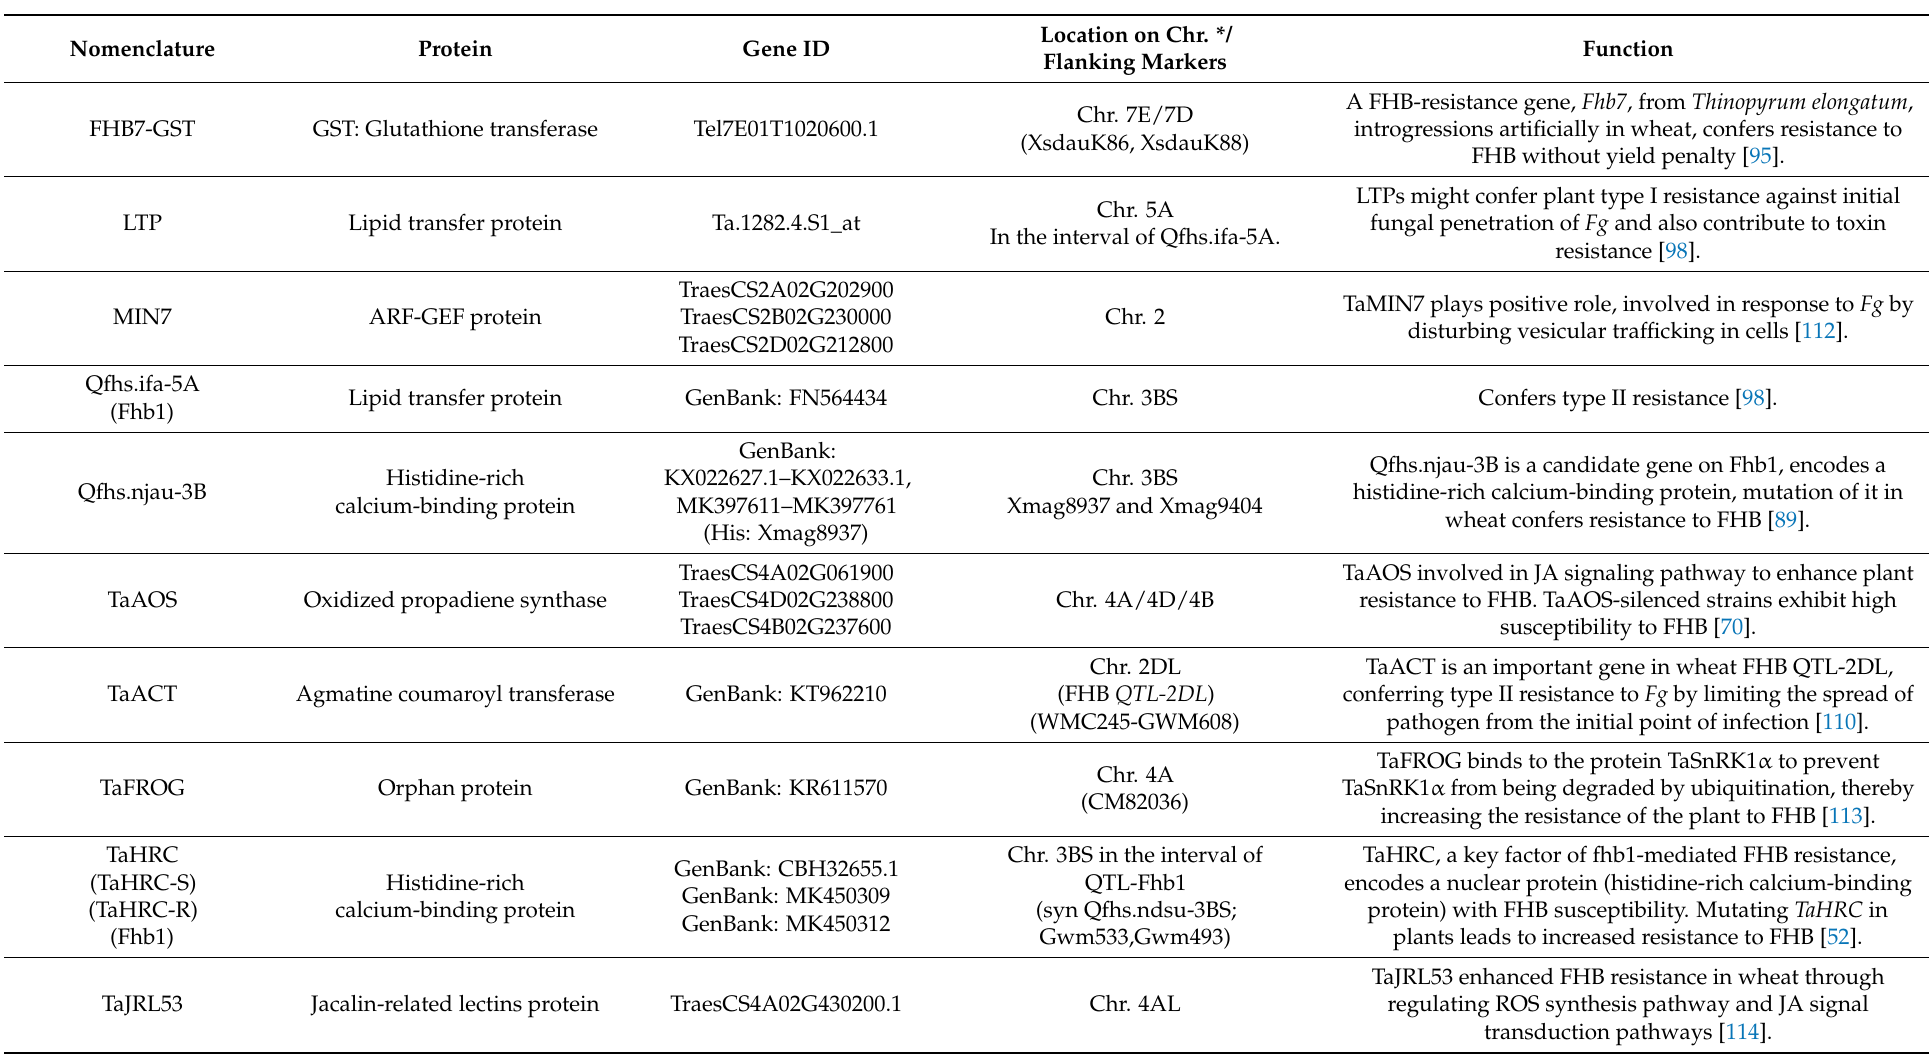
Table 2. Information on the resistance genes to FHB in